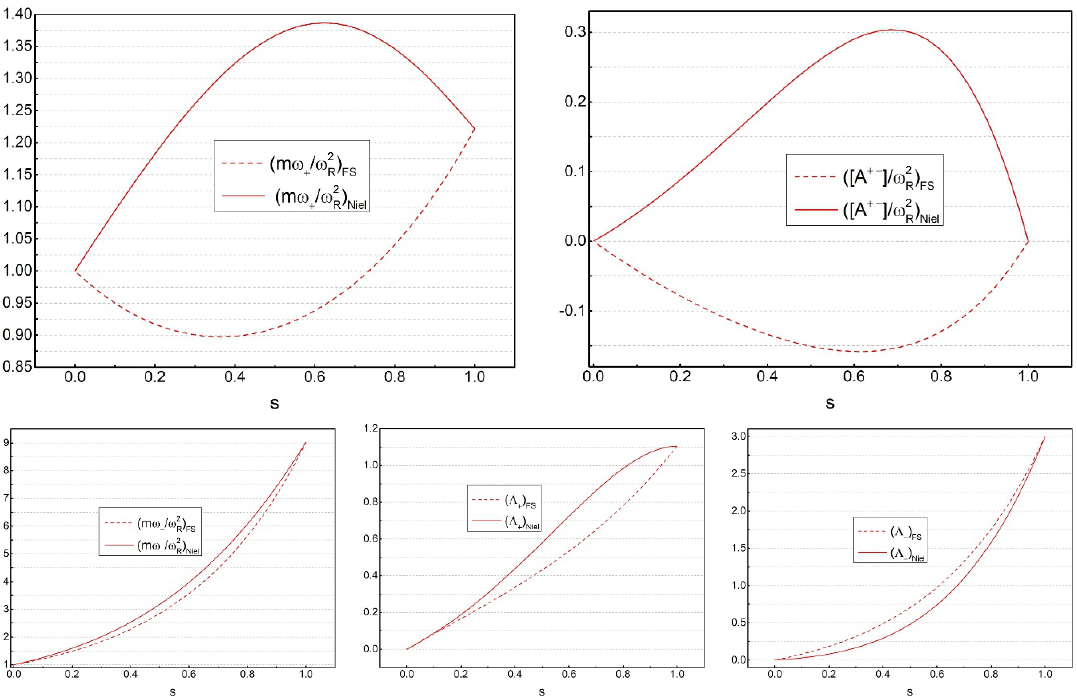
Figure 9 . Example of geodesics connecting the reference state to a same target state with both a (cid:6) nonvanishing using Fubini-Study metric and Nielson approaches. In this particular example, we chose m ! + ( s = 1) = 1 : 221 ; m ! (cid:0) ( s = 1) = 9 : 025 ; (cid:3) + ( s = 1) = 1 : 105 and (cid:3) (cid:0) ( s = 1) = 3 : 004. ! 2 R ! 2 R (Recall from eq. (2.24) that (cid:3) (cid:6) = [ A ] 0 (cid:6) =! 2 , and we de(cid:12)ned m! (cid:6) = [ A ] (cid:6)(cid:6) .) From this (cid:12)gure, we R see that the optimal circuits from the two approaches follow di(cid:11)erent trajectories even though they begin and end at the same states. This di(cid:11)erence appears most dramatically for m! + ( s ) =! 2 [ A ] + (cid:0) ( s ) =! 2 in the upper two R